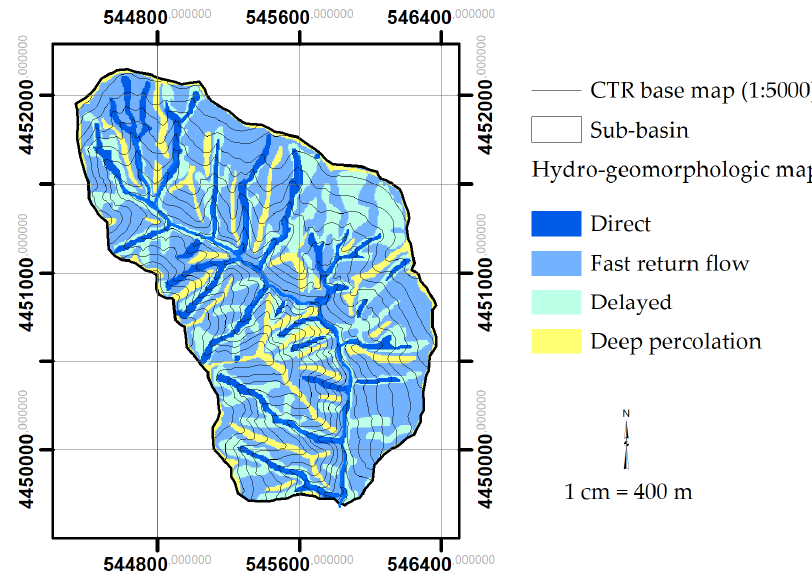
Figure 7. Object-based hydro-geomorphologic map of the Ciciriello catchment. About 50% of the Ciciriello catchment featured fast return flow components, with 25% featuring delayed return flow components; only minor contributions to the runoff were derived from direct and deep percolation (13% and 12%, respectively).